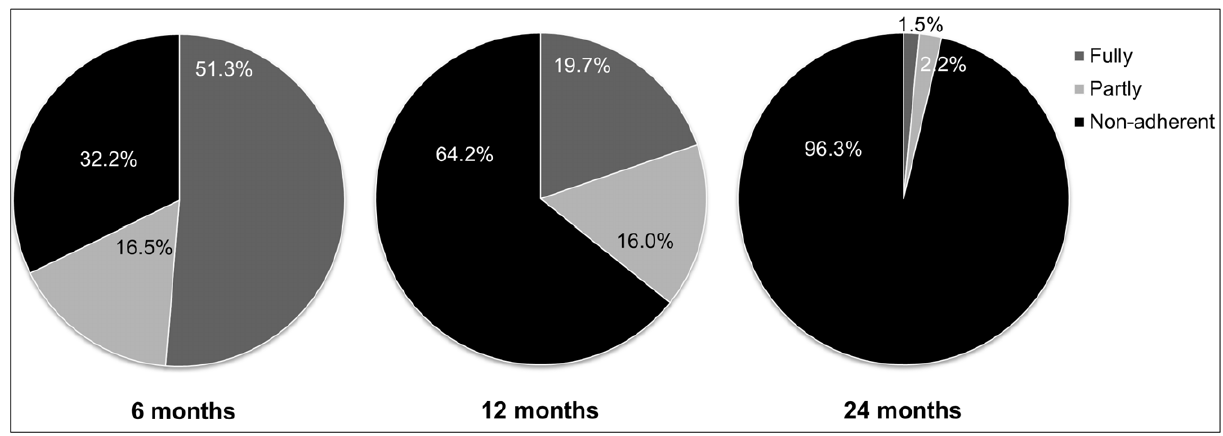
Figure 2. The proportion of Australian mothers (N=4990) who were fully, partly or non-adherent to the breastfeeding duration targets of six, 12, and 24 months or more for all of their